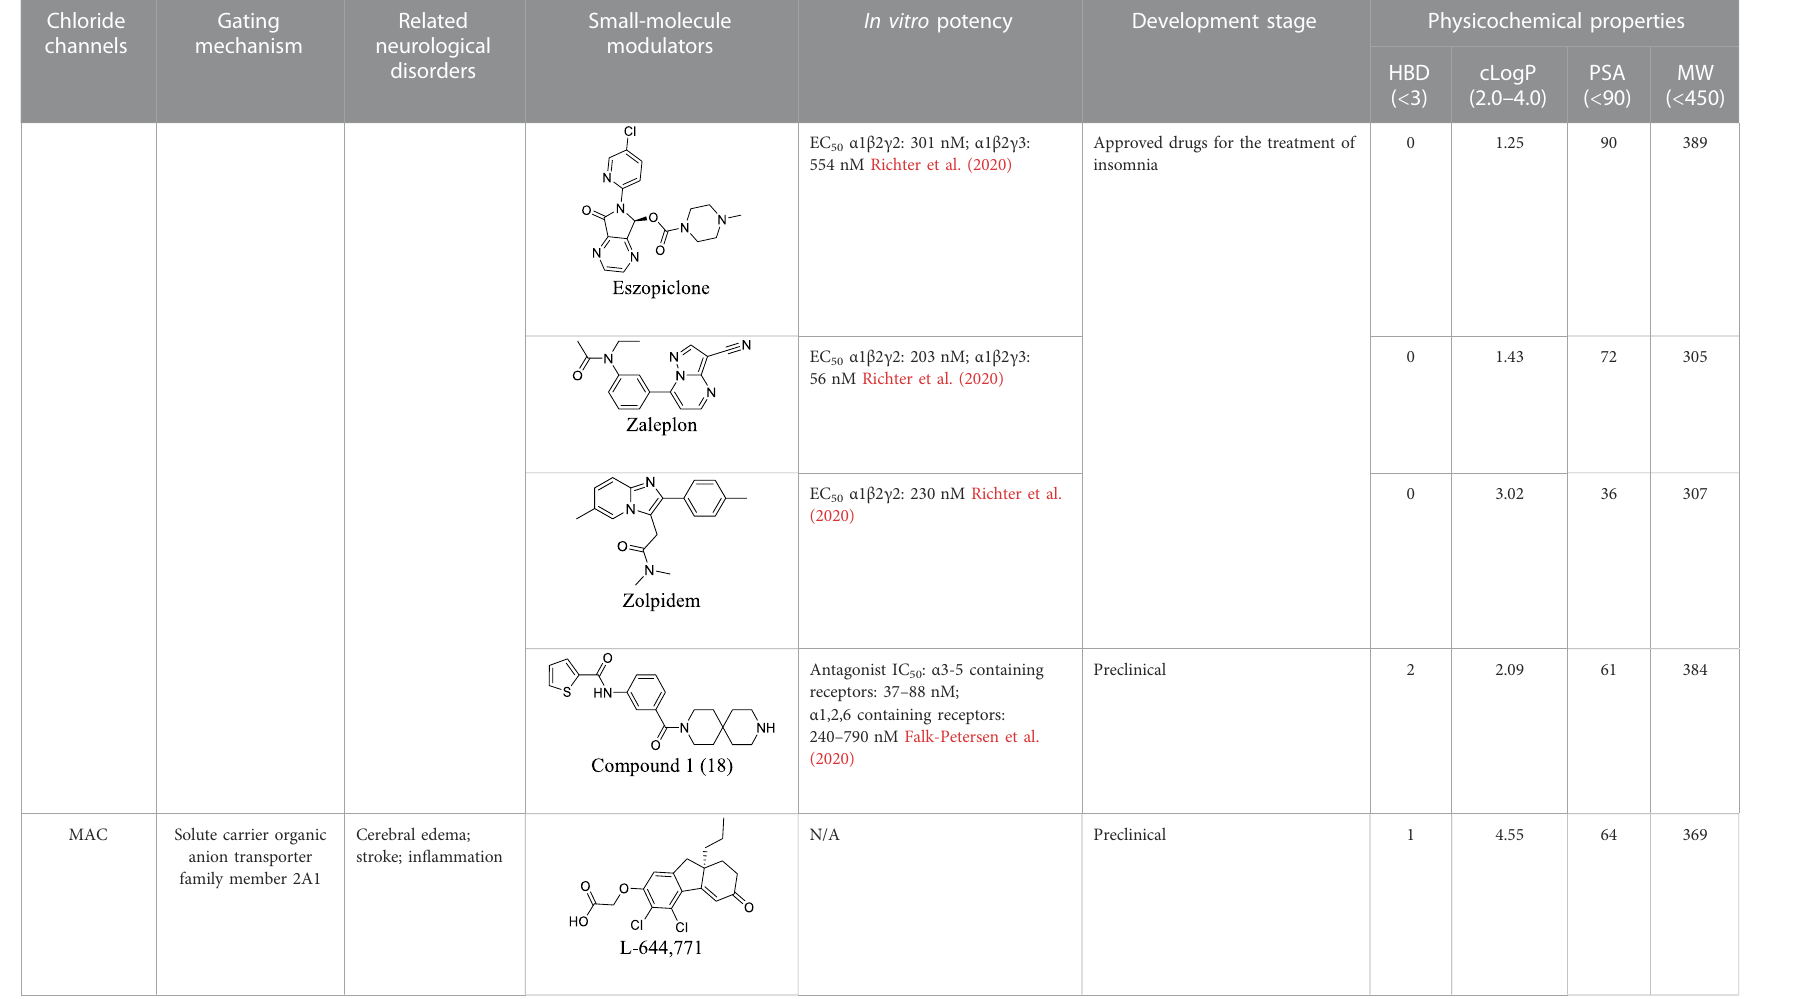
TABLE 1 ( Continued ) Summary of chloride channels involved in neurological disorders and their small-molecule modulators with physiochemical